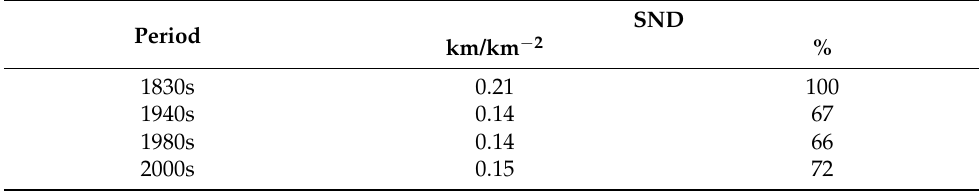
Table 3. SNDs in Plava River basin over different periods.